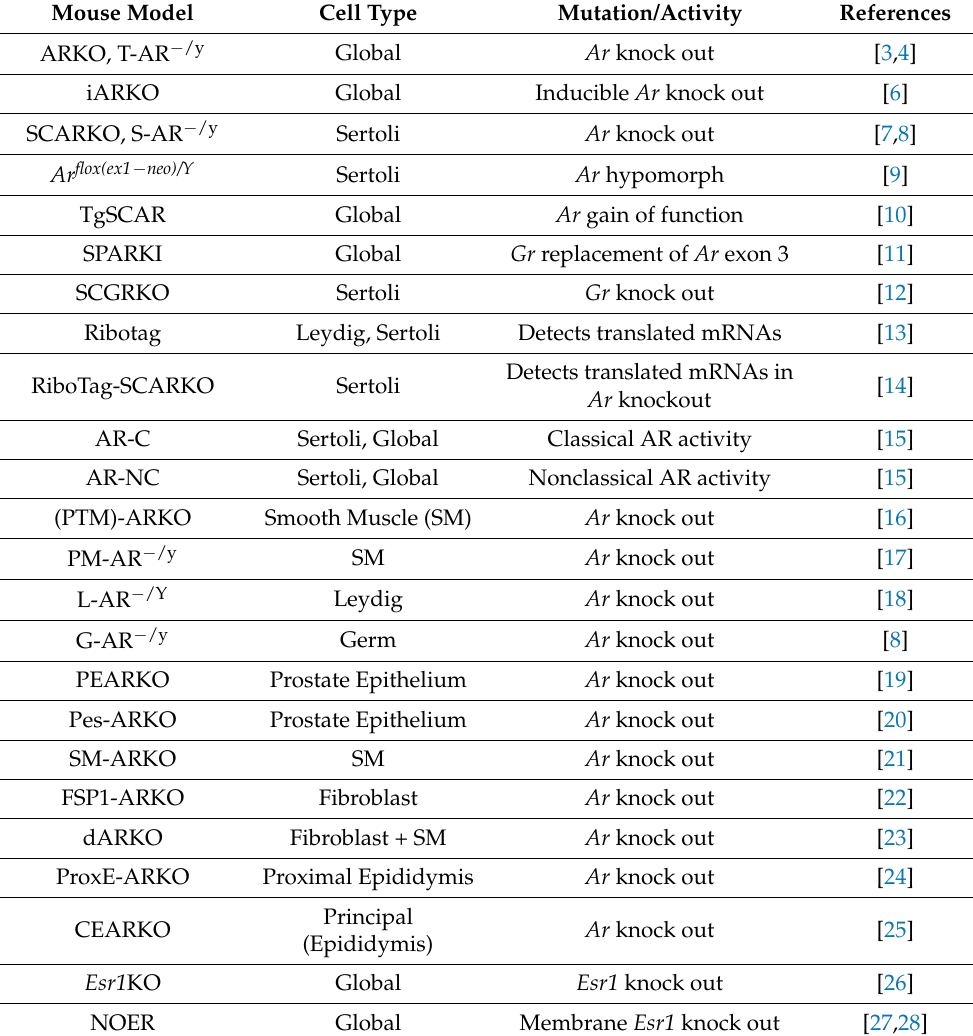
Table 1. Mouse Models Defining Steroid Hormone Actions in the Male Reproductive